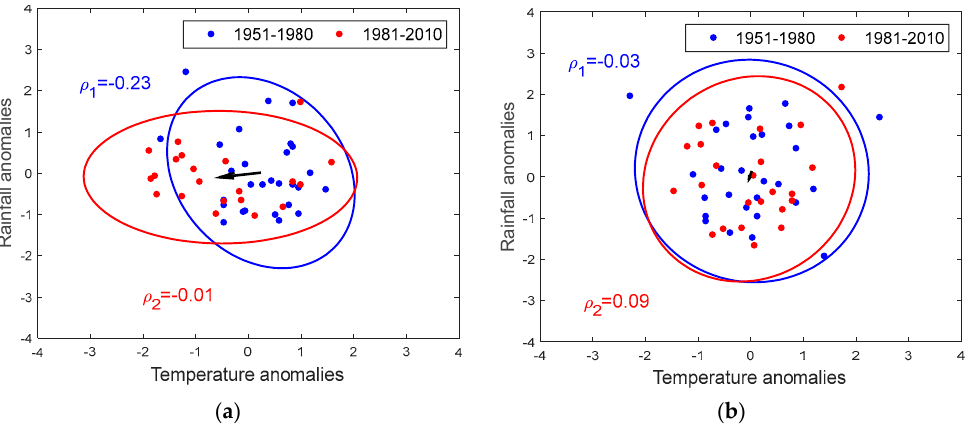
Figure 3. The 95% confidence ellipses for the spring season at gauge ( a ) 930; ( b ) 1010.